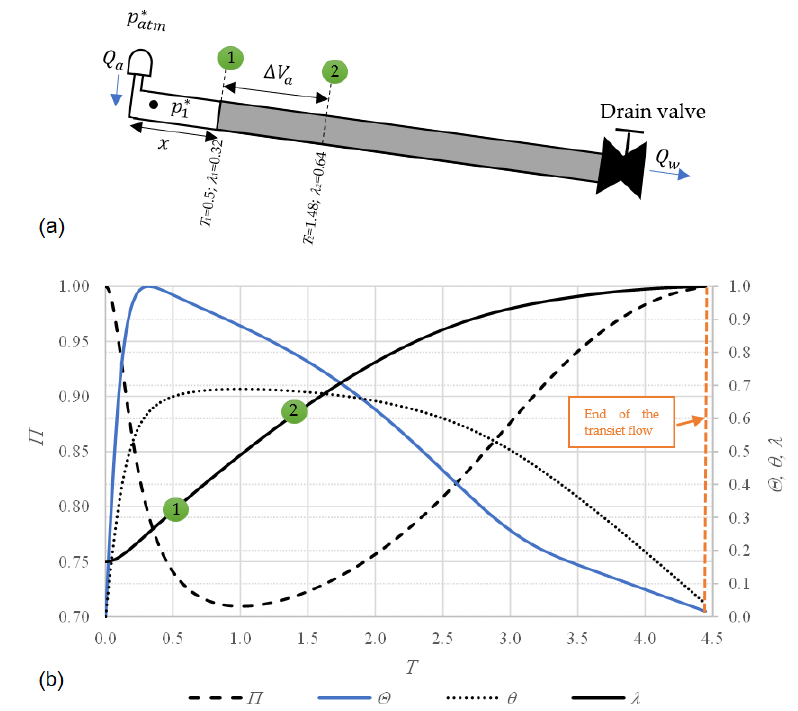
Figure 8. Representation of an emptying process: ( a ) schematics of air pocket expansion; ( b ) evolution of hydraulic and thermodynamic